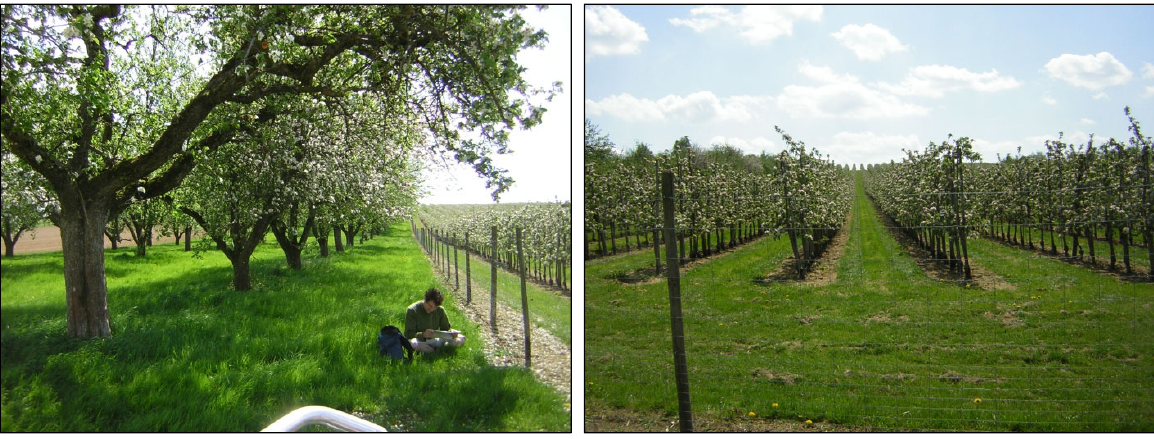
(a) An orchard meadow, with standard-sized fruit trees and a meadow